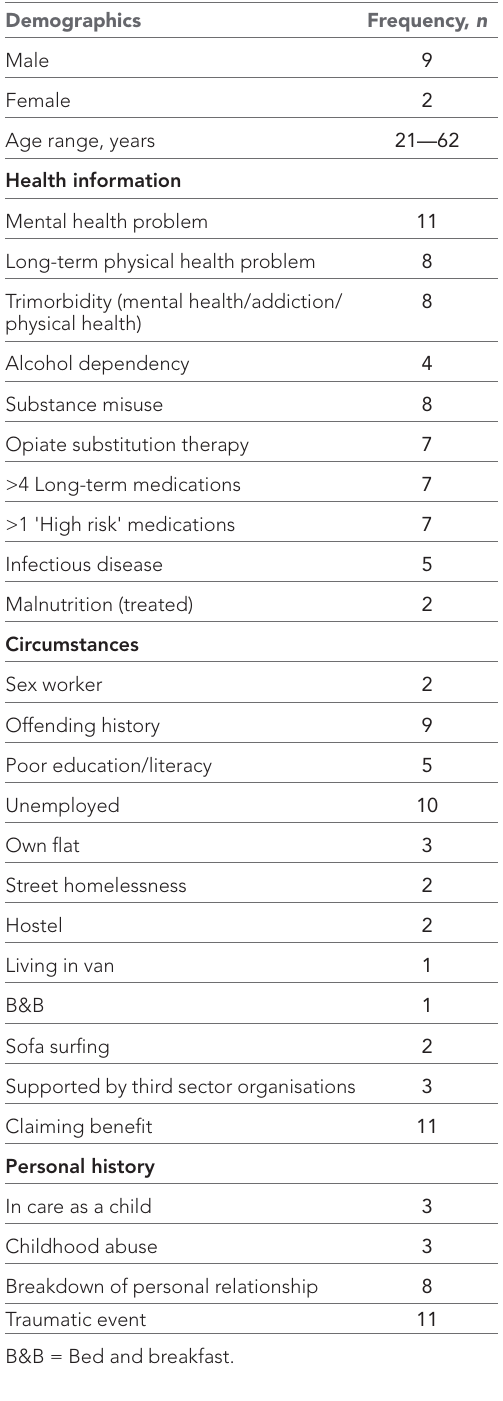
Table 1 Participant characteristics for 11